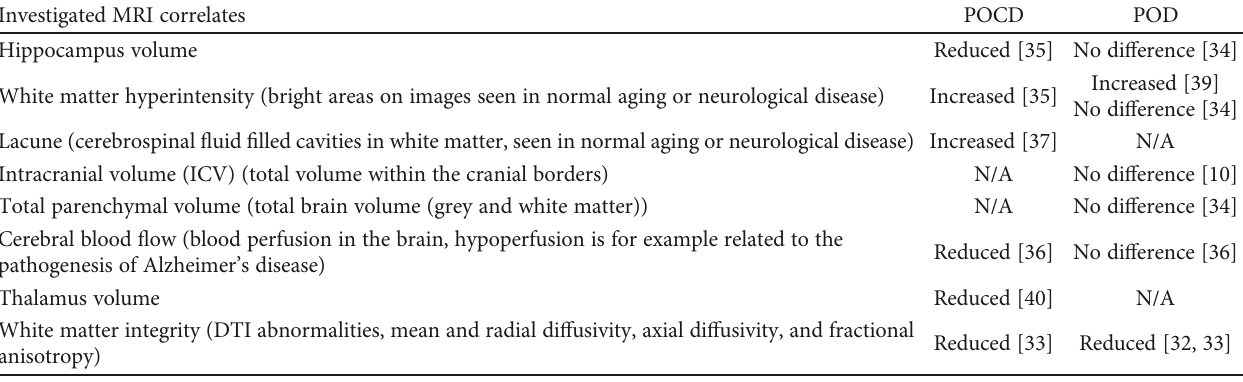
Table 3: Overview of MRI fi ndings in postoperative cognitive dysfunction (POCD) and delirium (POD), respectively.